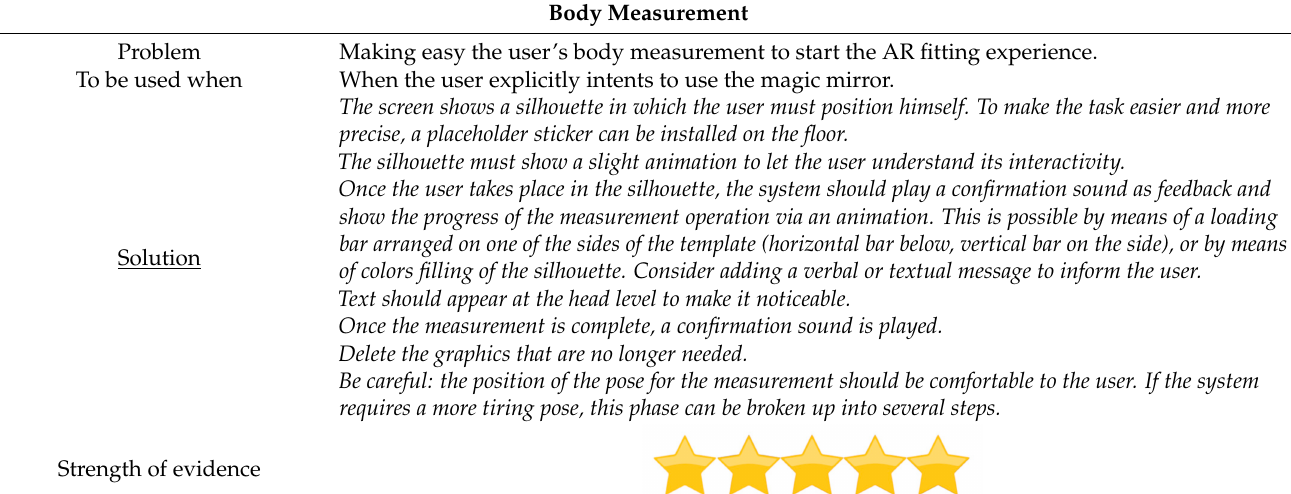
Table 3. Body measurement pattern. Body Measurement